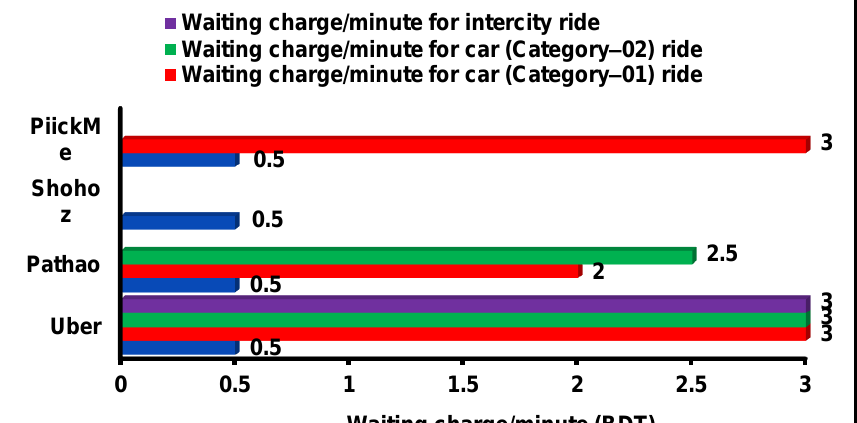
Fig. 8. Comparison based on waiting charge/minute for a ride.